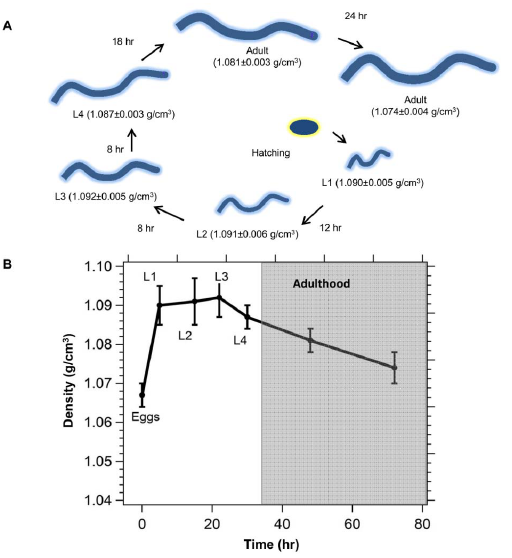
Figure 2. Density is a function of the developmental stage of C. elegans . (A) Schematic of the change in density as a function of life cycle. (B) Plot of the mean density of the worms versus time with the bars in the plot indicating one standard deviation of the normal distribution that was fitted to the density distribution curves of a representative population worms at each life stage.